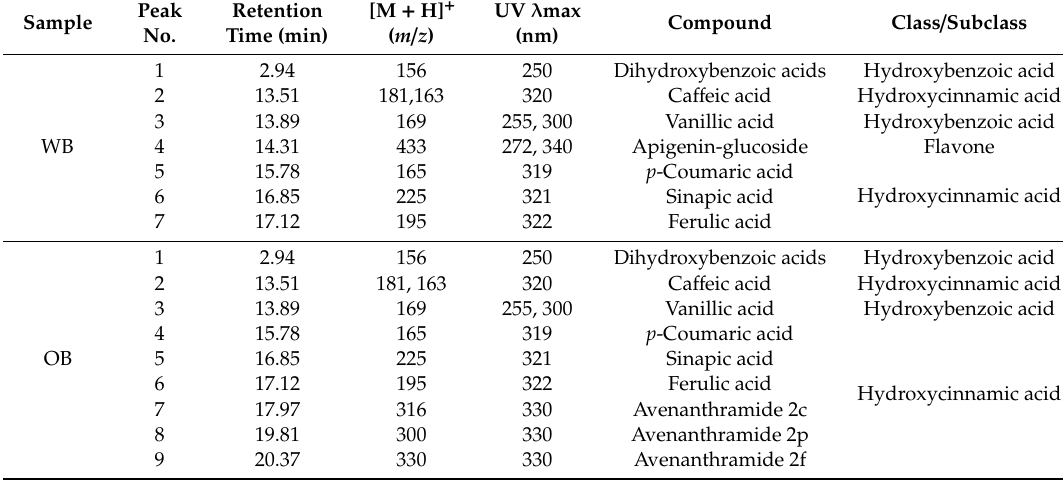
Table 1. Identification of phenolic compounds in fresh / thermally processed samples of wheat bran (WB) and oat bran (OB).